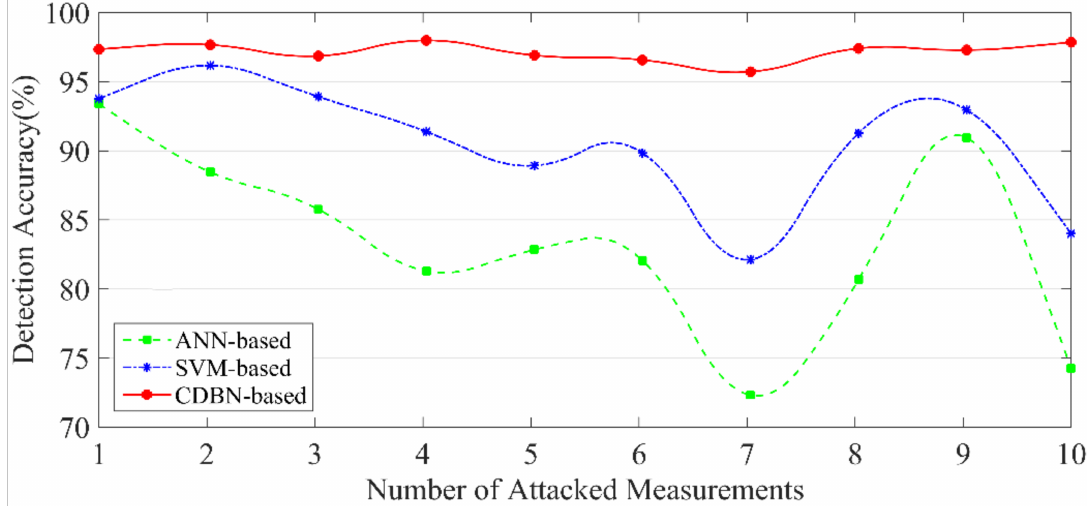
Figure 9. Accuracy of different number of attacked